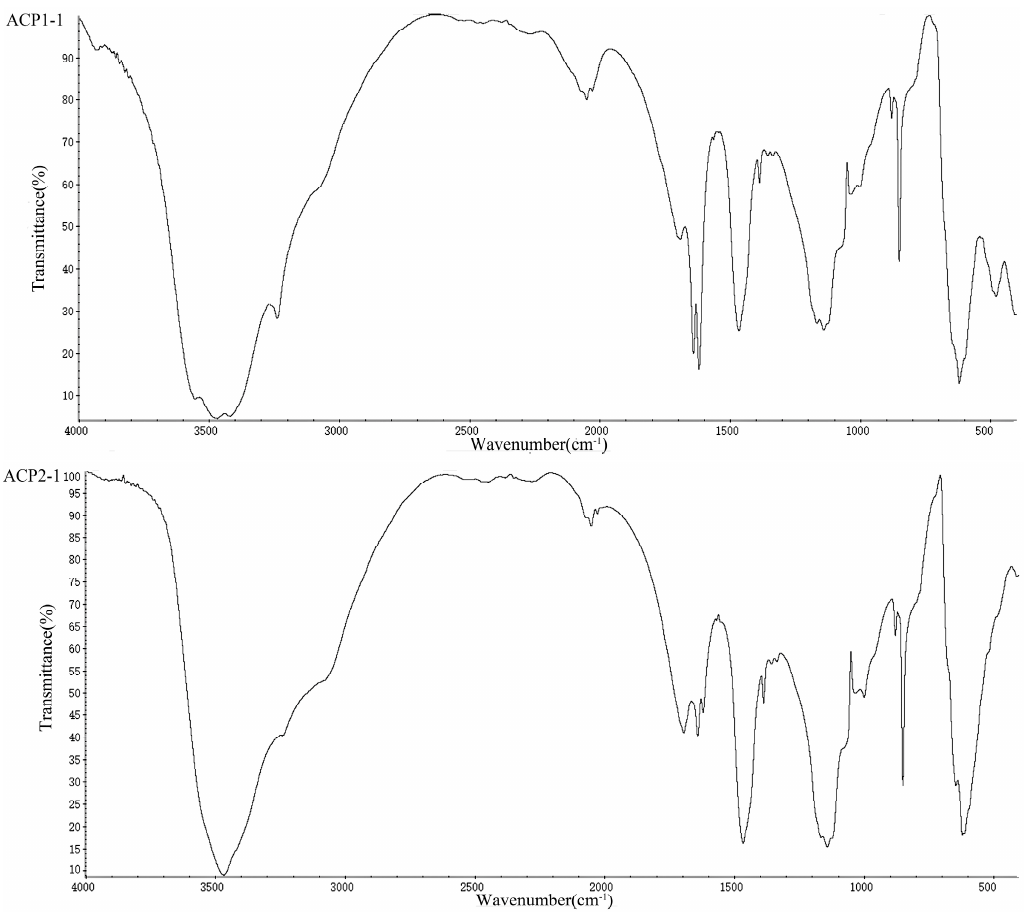
Figure 3. FT-IR spectrum of the ACP1-1 and ACP2-1 polysaccharide fraction.